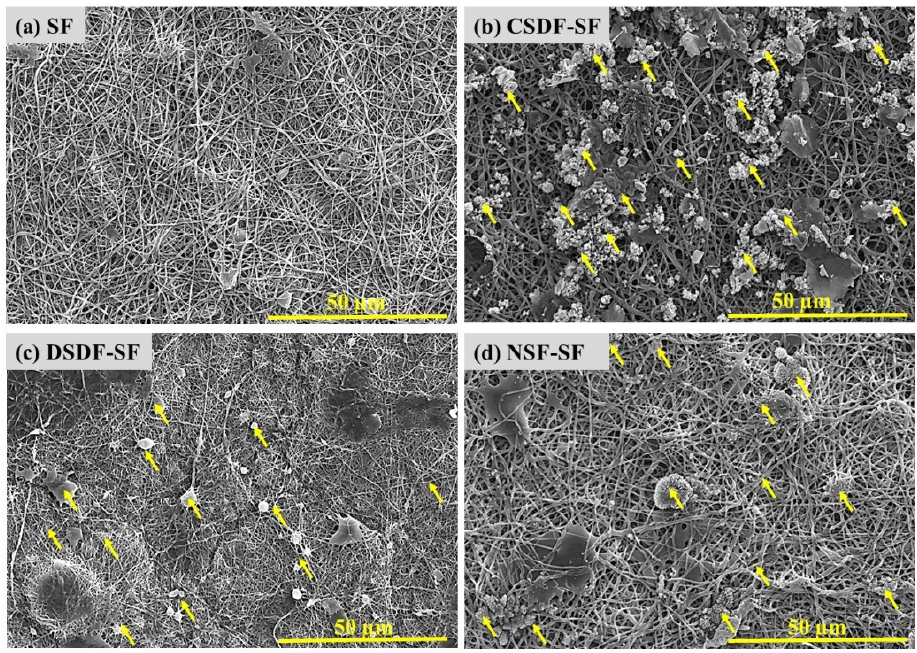
Figure 2. Scanning electron micrographs of uncoated and coated electrospun SF membranes, yellow arrows represent Ag deposition.